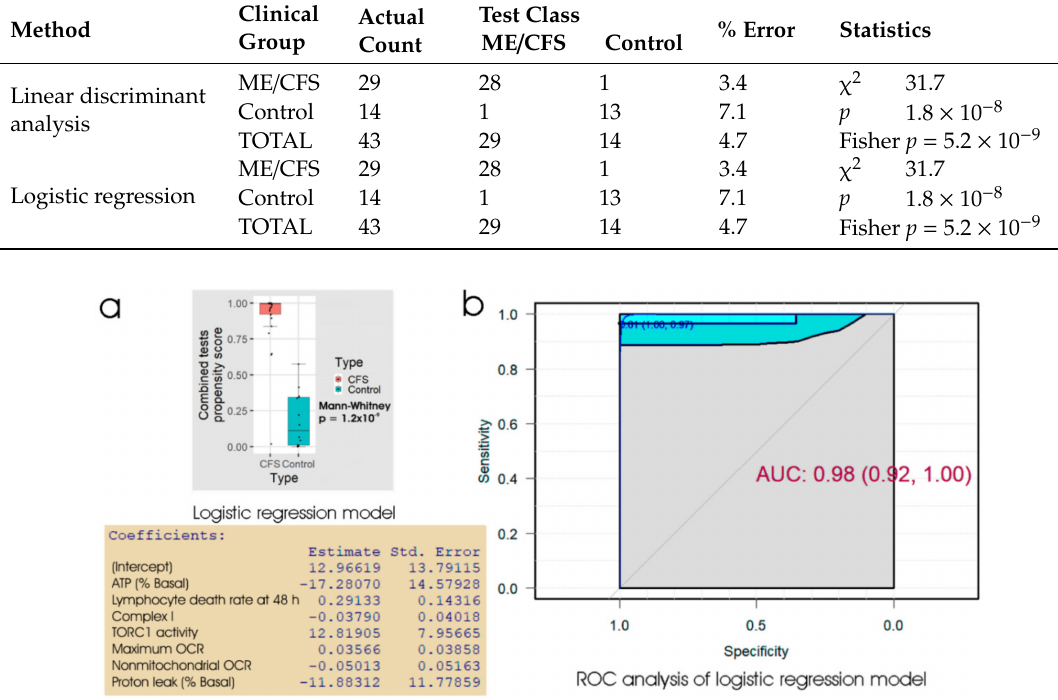
Table 4. “Confusion matrix” analysis of combined tests.